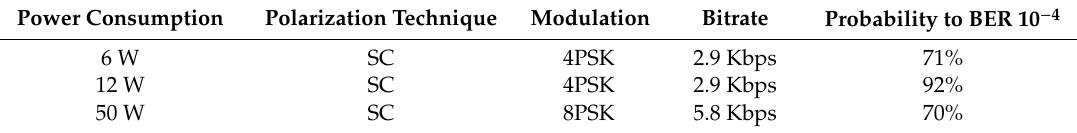
Table 2. Application